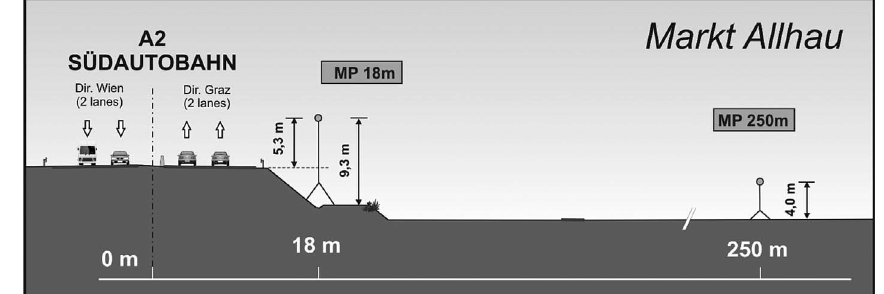
Figure 1. Markt Allhau: MP 250 m is 3 m under the surface of the